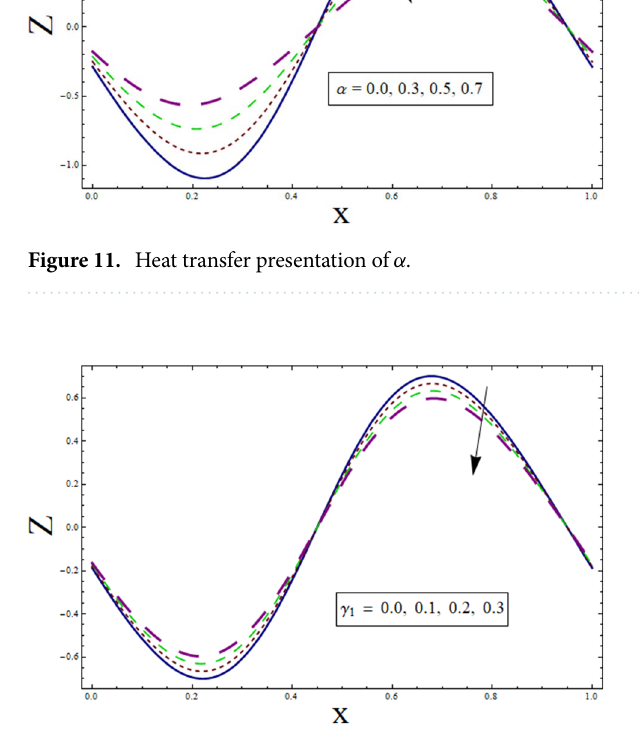
Figure 12. Heat transfer presentation γ 1 .